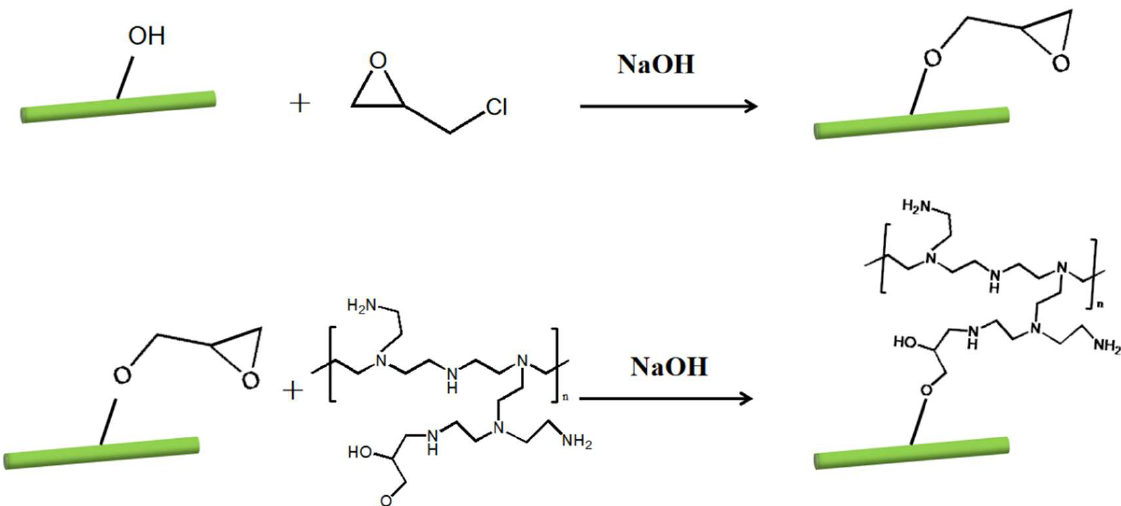
Figure 1. Schematic preparation of the LCNF–PEI.